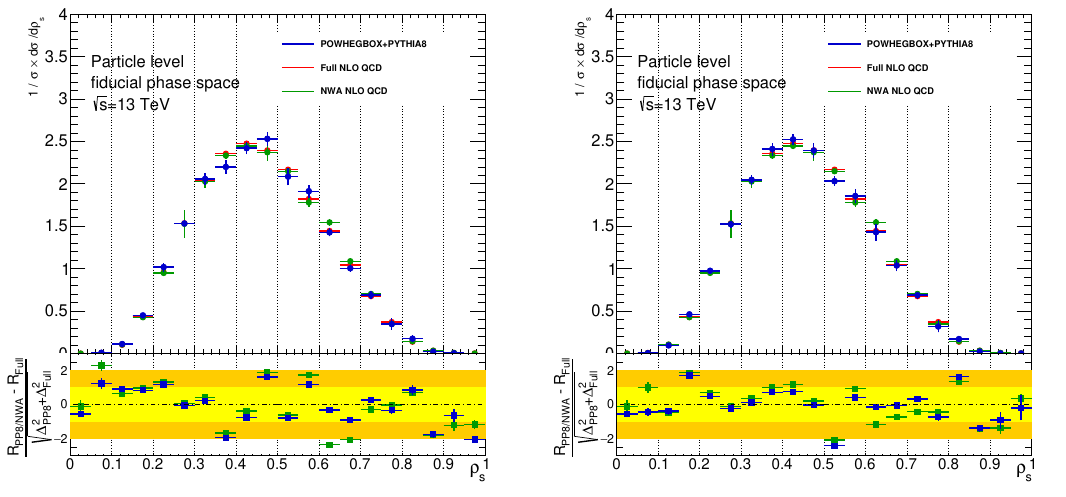
Figure 37 . Comparison between the R distributions computed using Powheg-Box + Pythia 8 (blue), the calculation including off-shell and non-resonant contributions as well as finite width ef- fects ( Full NLO ) [72] (red) and the calculation in the NWA [72] (green). Error bars refer to statistical uncertainties of the MC simulation. The lower plots show the differences between predictions of the Powheg-Box + Pythia 8 or NWA and those of the full calculation, normalized to the statistical uncertainty. The yellow (orange) area represents the 1 σ (2 σ ) band, where the standard deviation is calculated as the quadratic sum of the uncertainties of the two calculations, the statistical uncer- tainty of Powheg-Box + Pythia 8 prediction due to a finite number of simulated events, and the uncertainty from the numerical MC integration of the Full NLO calculation. The uncertainties of the Powheg-Box + Pythia 8 computation dominates the total uncertainty. The distribution on the left (right) is computed setting the parameter hdamp of Powheg-Box to m t (infinity).